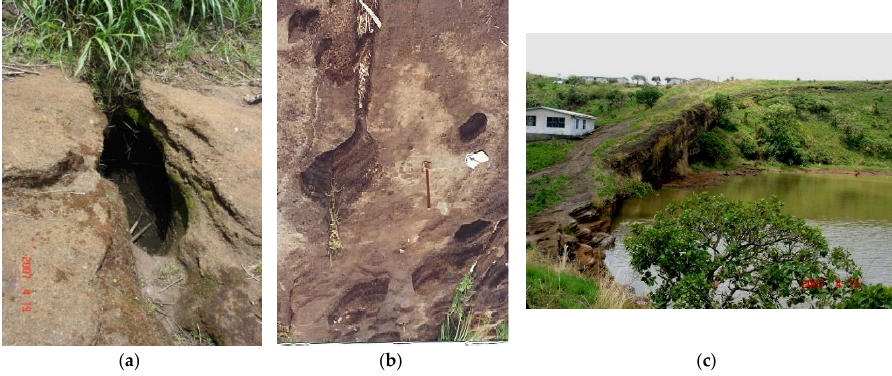
Figure 12. ( a , b ) Large potholes are aligned on fractures. These potholes focus on erosion and landslides; ( c ) mechanical erosion around the dam west flank of Lake Nyos. (Source: fieldwork in April 2007 and June